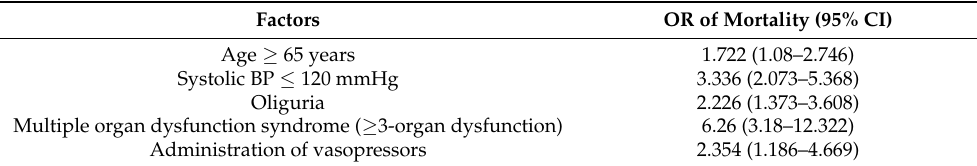
Table 3. Associations of variables and mortality of patients with dialysis-dependent acute kidney injury in the model of multivariable logistic regression analysis. (Model 1)